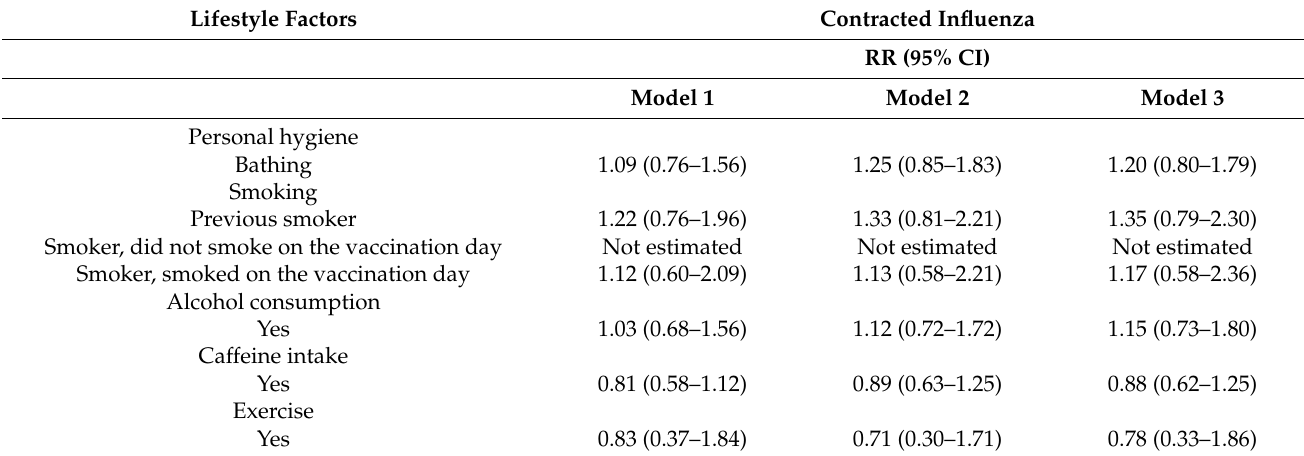
Model 1. Rough analysis; Model 2. Adjusted for sex/age/underlying conditions; Model 3. Adjusted for sex/age/underlying condi- tions/lifestyle, CI, confidence interval; RR, risk